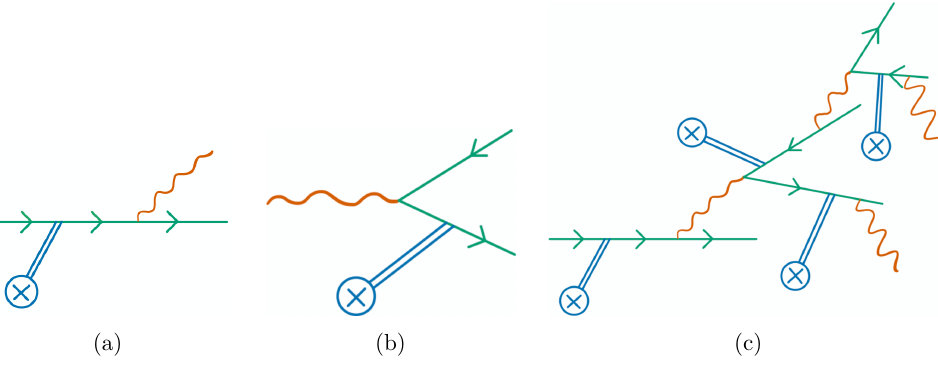
Figure 10. Some SFQED interactions of quantized particles in classical background fields. (a) Nonlinear Compton scattering, (b) pair creation in a background field, and (c) a fermion incident on a background field causes the field to decay into a QED